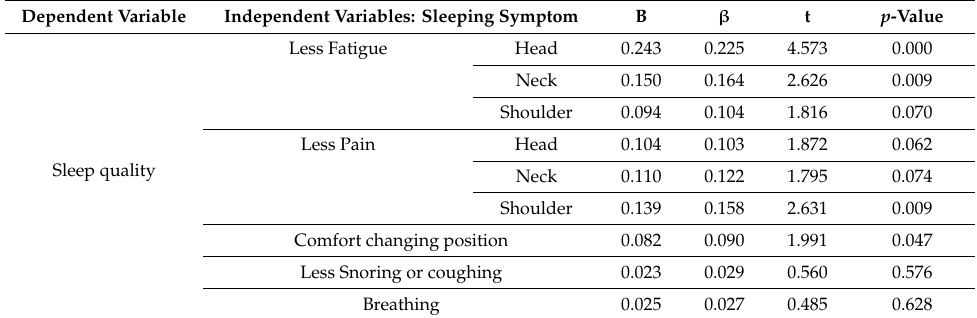
Table 7. Results of regression analysis between sleeping symptoms and sleep